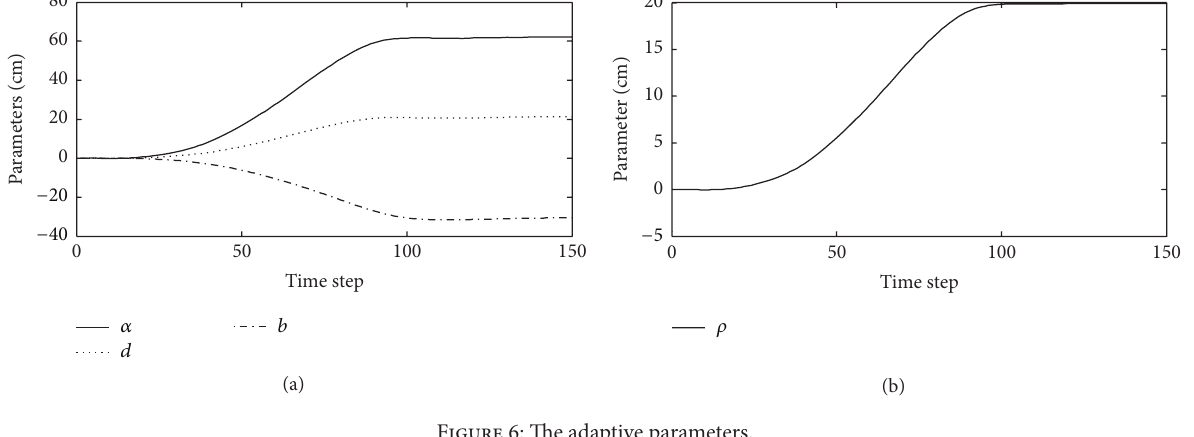
Figure 6: The adaptive parameters.